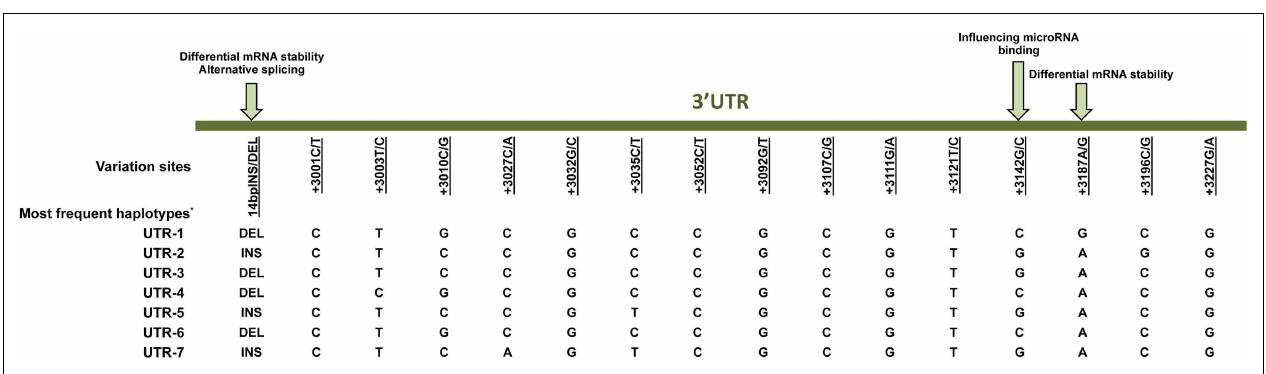
FIGURE 2 |Variation sites at the 3 (cid:48) untranslated region (3 (cid:48) UTR) of the HLA-G gene that may influence HLA-G expression . Polymorphic sites associated with diseases presented in this review are underlined. Arrows